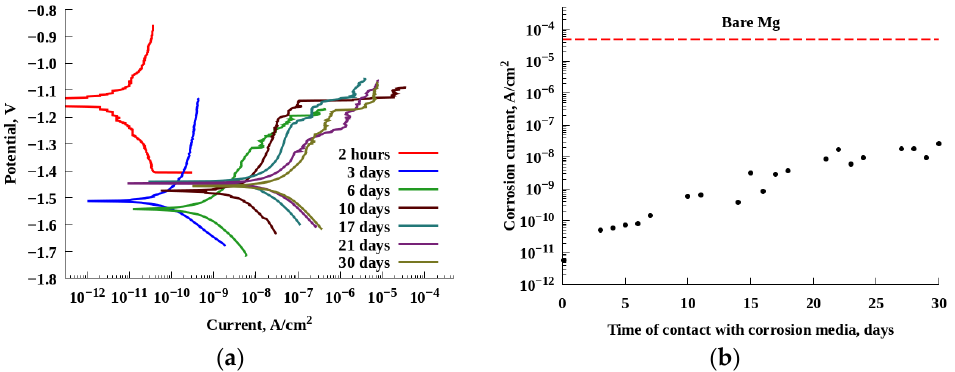
Figure 3. The evolution of potentiodynamic polarization curves ( a ) and corrosion current density ( b ) for the superhydrophobic sample subjected to continuous contact with 0.5 M NaCl for 30 days. The dashed line in ( b ) shows the value of the corrosion current density for the polished MA8 sample after 2 h of contact with the same electrolyte.